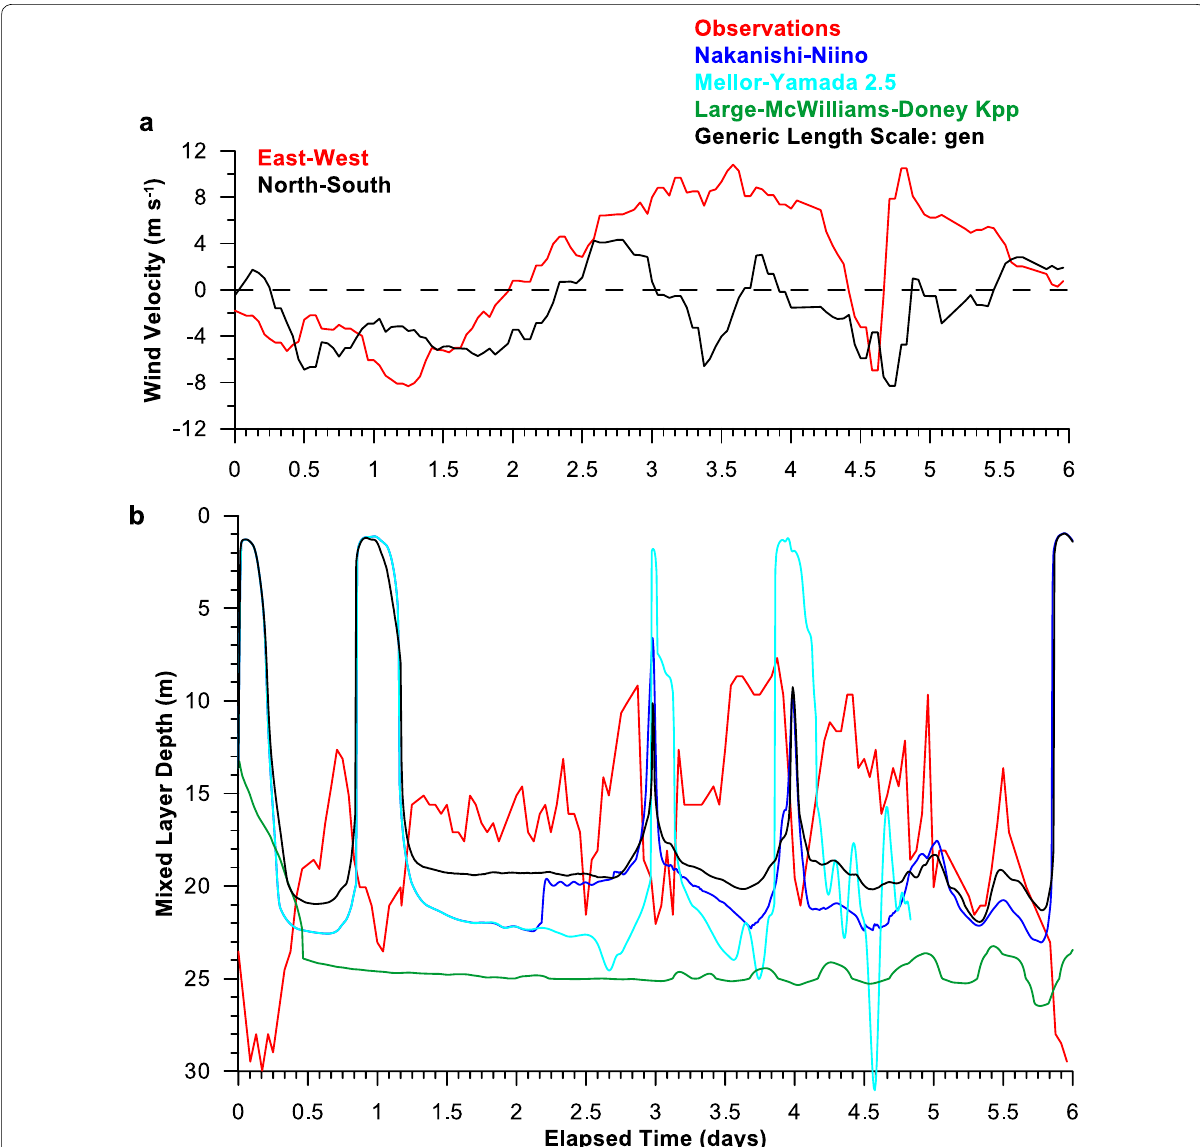
vertical mixing